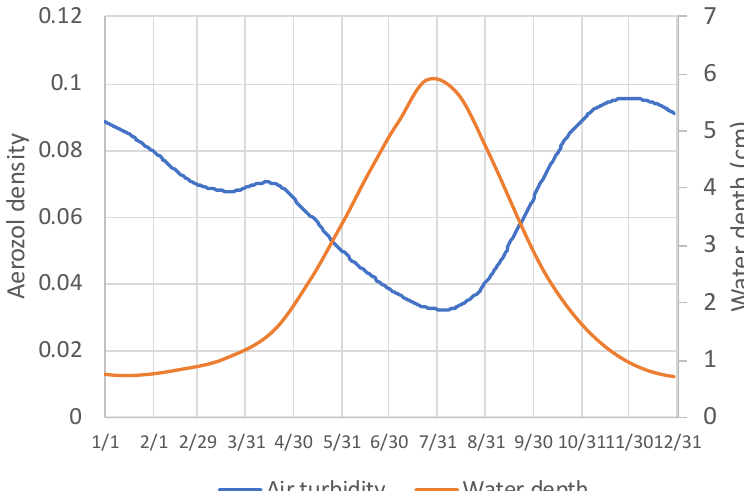
Figure 8. Seasonal fluctuation of the atmospheric parameters around the University of Miyazaki, taken by the curve-fitting method to the spectral profile modeled by Spectrl2 [95]. The trend line was defined by the local least-square-error method.